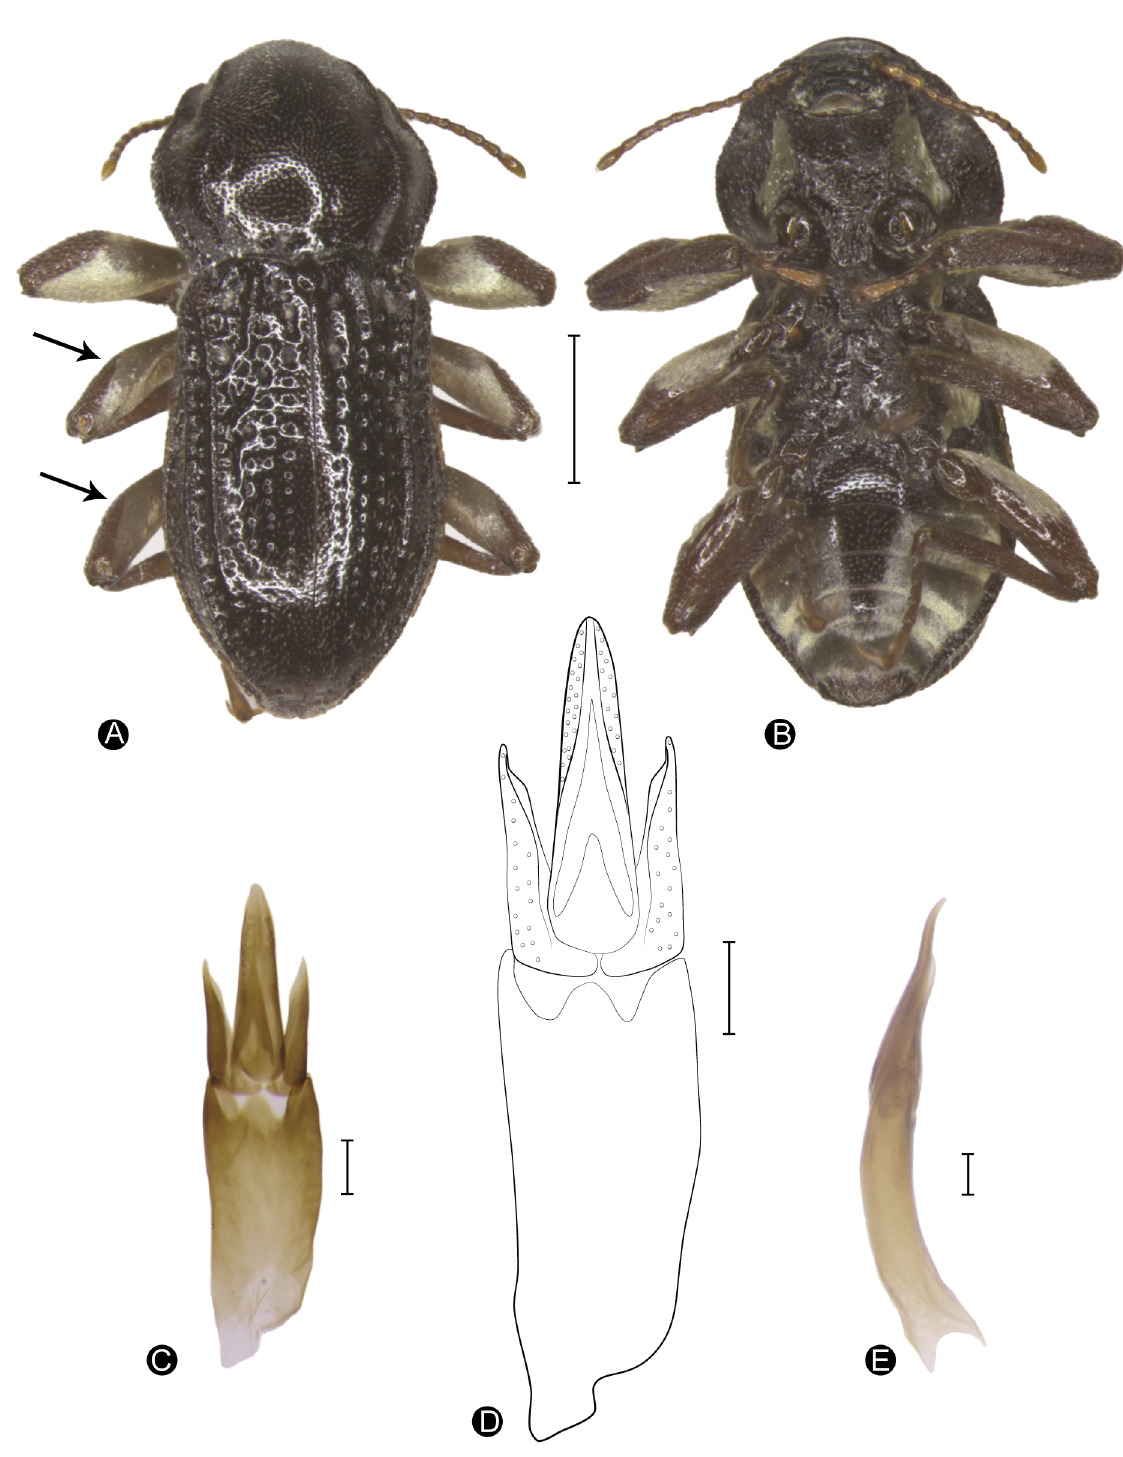
Fig. 9. Spanglerelmis timburi Polizei & Bispo gen. et sp. nov. holotype, ♂ (MZSP31520). A – B . Habitus. A . Dorsal view (arrows showing the pattern of tomentum on femur). B . Ventral view. C – D . Aedeagus in ventral view. E . Aedeagus in lateral view. Scale bars: A–B = 0.5 mm; C–E = 0.1